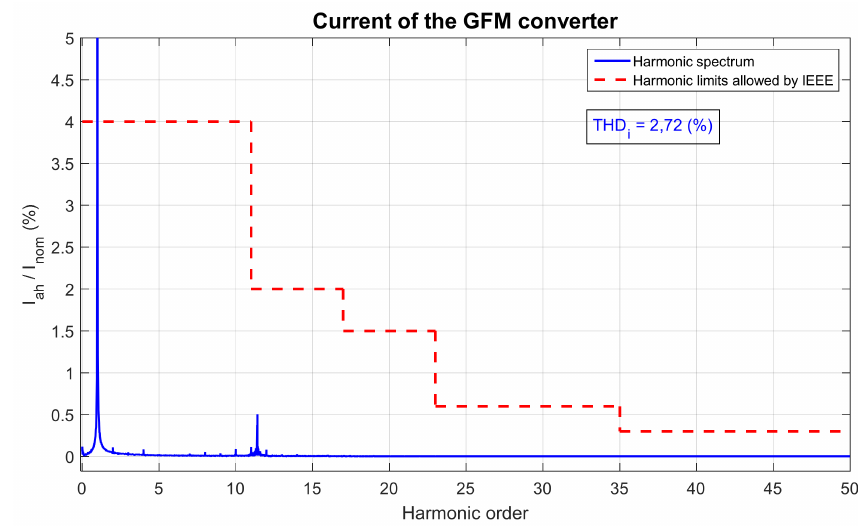
Figure 24. Frequency analysis of harmonic